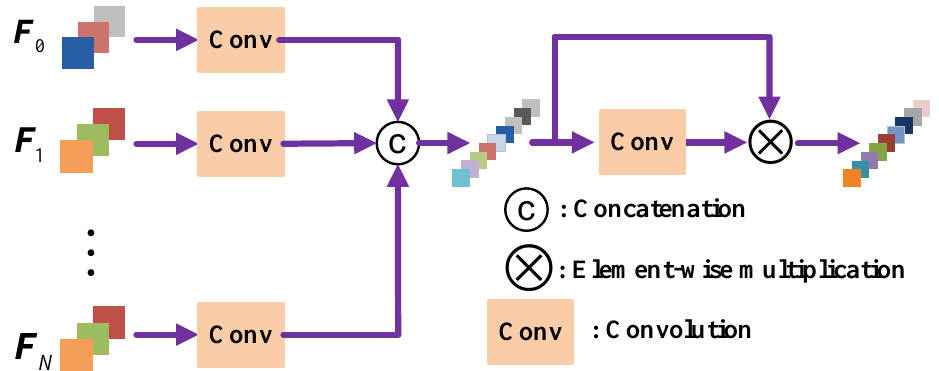
Figure 3. The detailed structure of the designed feature aggregation